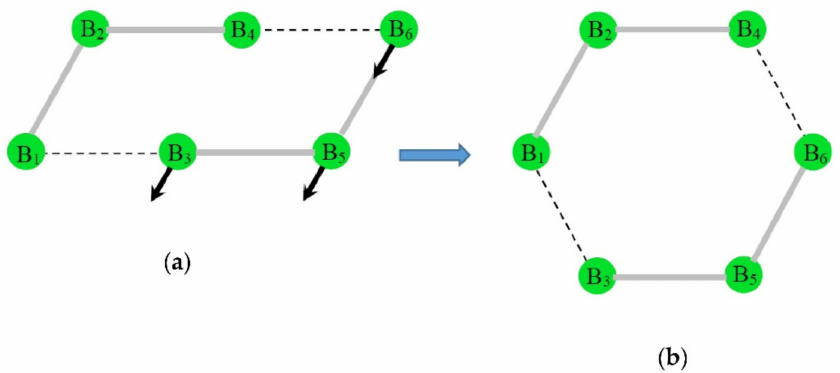
Figure 6. Simplified representation of the 3D → 2D isomerization of hexaborane(12): ( a ) 2D projec- tion of the boron frame in reactant (R) C 2 hexaborane(12), ( b ) boron frame in 2D product (P) D 3h hexaborane(12). The black arrows indicate the displacement of the B(3)B(5)B(6) moiety down parallel along the B(3)-B(4)